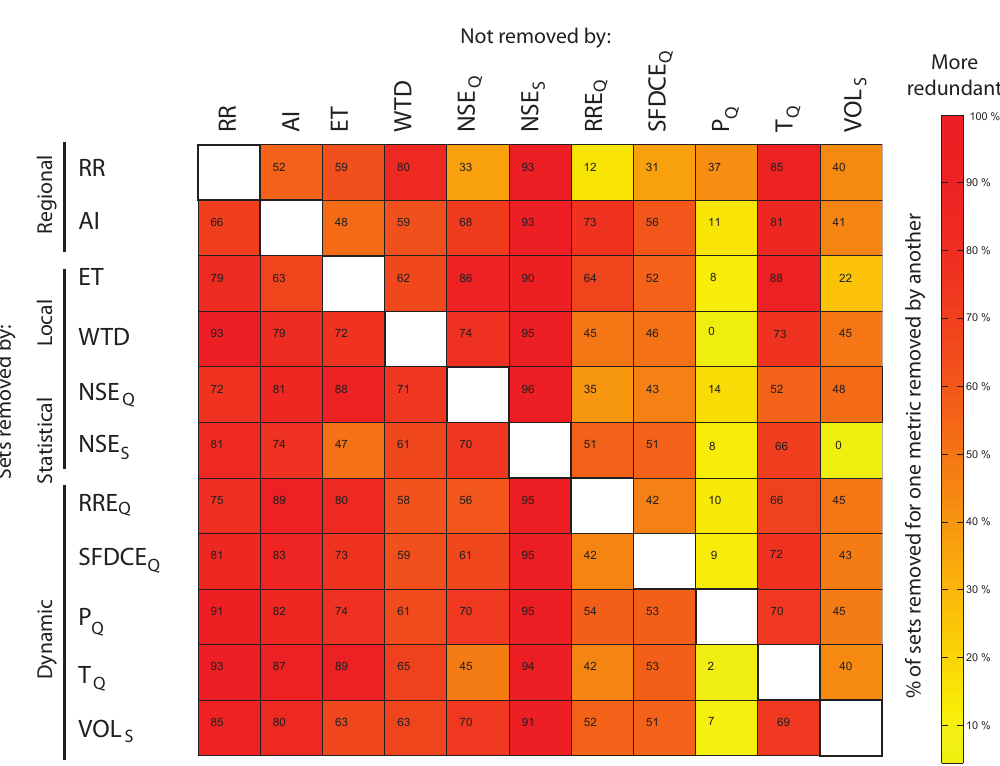
Figure B2. Redundancy across different metrics. The percentage of non-behavioral sets removed by criteria are applied to one metric ( x axis) that is not removed by another ( y axis).